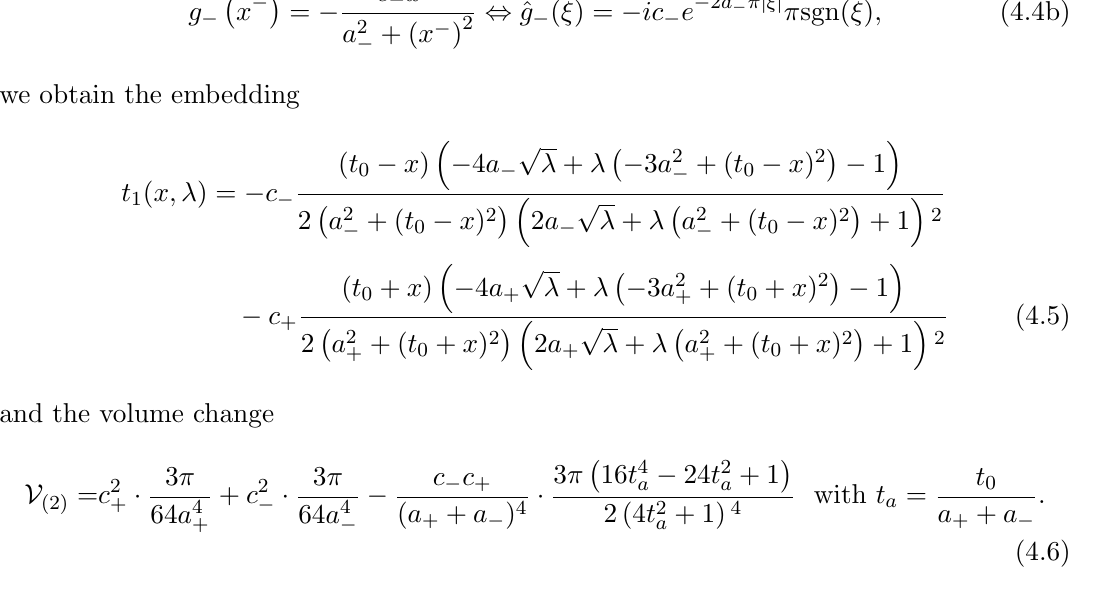
(^ g + ; ^ g (cid:0) ) for example 1, respectively (cid:0)V (2) ; mixed (^ g + ; ^ g (cid:0) ) ! (2) ; mixed